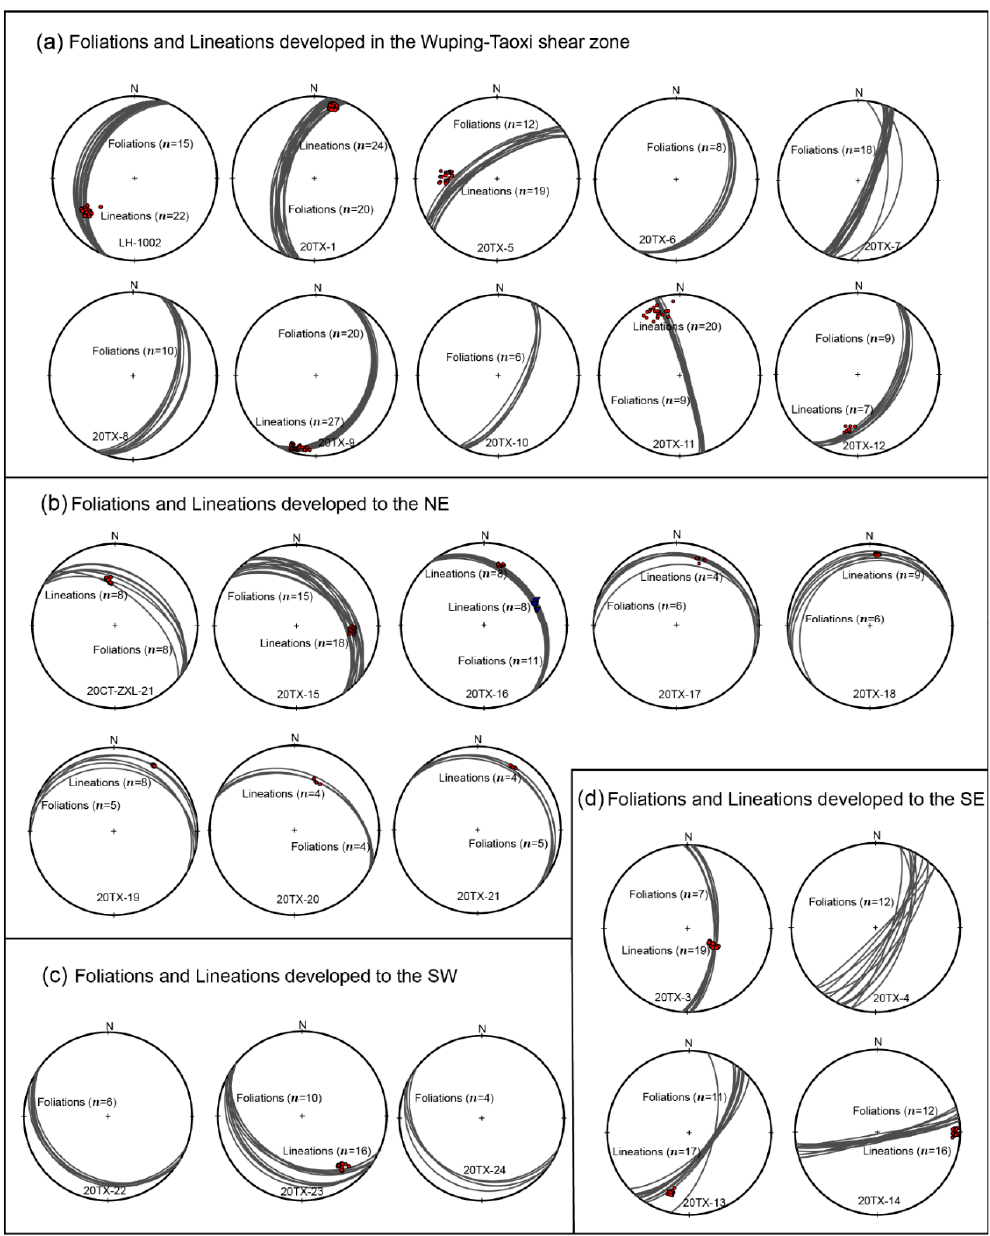
Figure 2. Lower-hemisphere, equal-angle stereograms of geometric fabrics in the Taoxi dome. ( a ) Geometric fabrics developed in the Wuping–Taoxi shear zone show NE-trending shear plane and sub-horizontal mineral stretching lineation. ( b ) Geometric fabrics developed in the northeastern part of the Taoxi dome show a NE-dipping shear plane and two groups of lineations, one of which downdip to the NE and another is NW–SE striking. ( c ) Geometric fabrics developed in the southwestern portion of the Taoxi dome show a SW-dipping shear plane and sub-horizontal min- eral stretching lineation. ( d ) Geometric fabrics developed in the southeastern portion of the Taoxi dome show SE-dipping and two groups of lineations, one of which downdip to the SE and another is